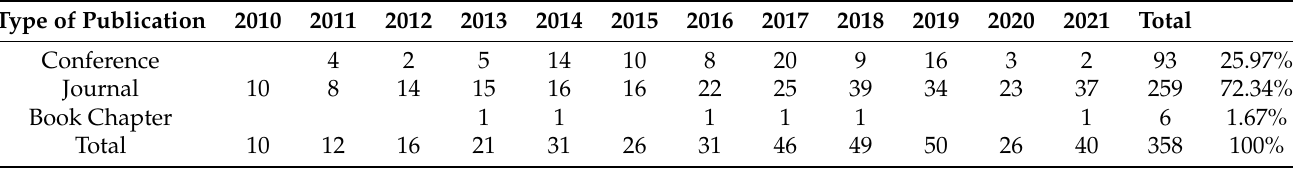
Table 1. Distributions over publication types.